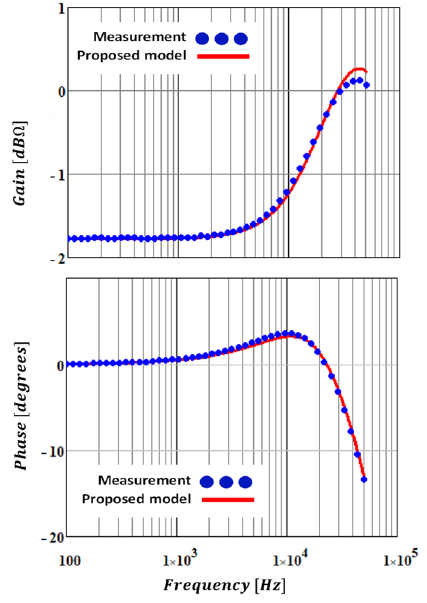
Figure 22. Frequency response of the open-loop output impedance, 8.5 W.